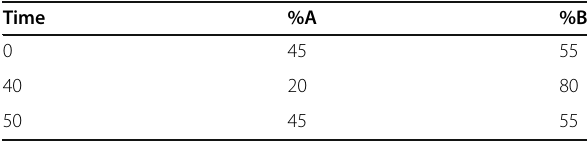
Table 1 Gradient scheme for bedaquiline stability